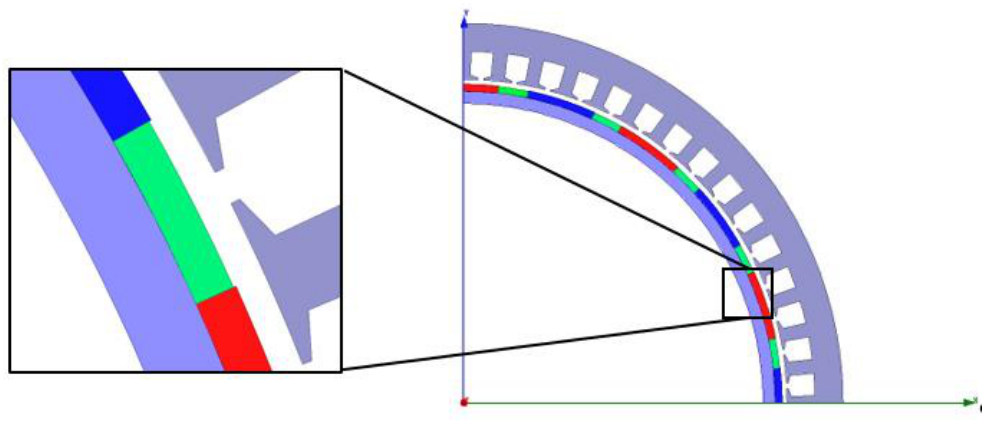
Figure 1. 1 / 4 model of surface-mount BLDC motors. Figure 1. 1/4 model of surface-mount BLDC motors.